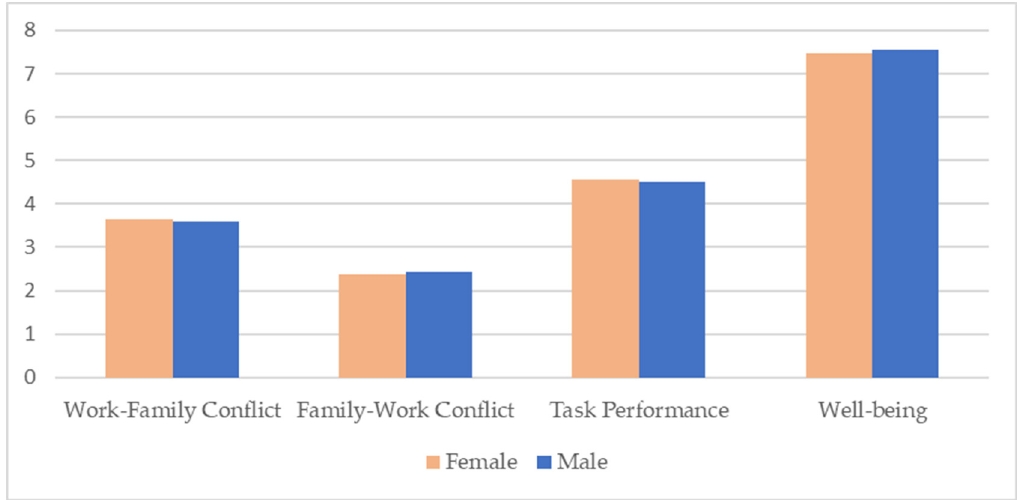
Figure 2. Distribution of variables according to gender .